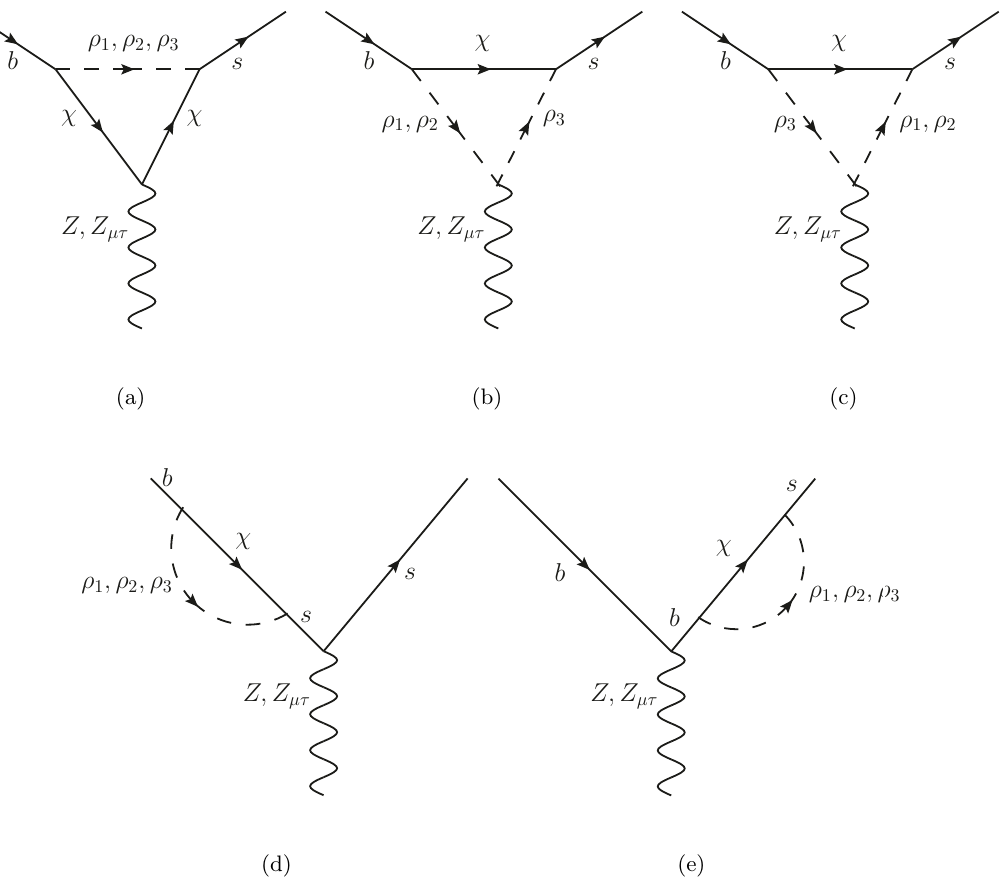
Figure 1 . Z and Z (cid:22)(cid:28) -penguin and self-energy diagrams that contribute to the decay of b in addition to SM